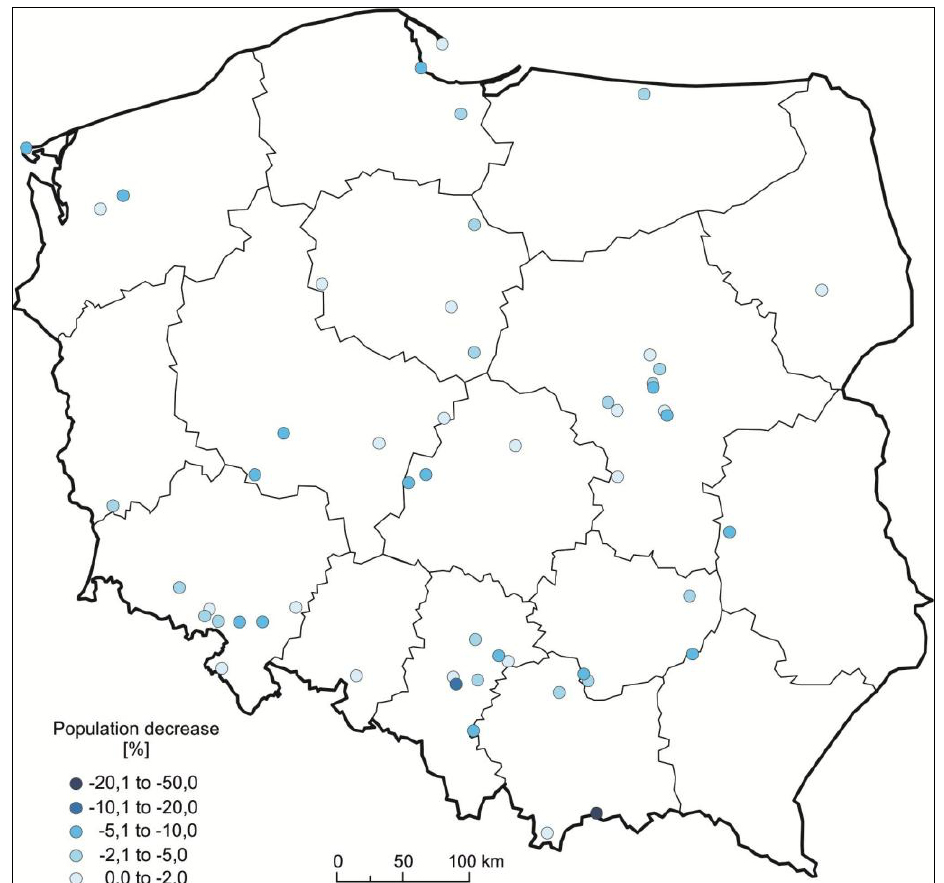
Fig. 5. Population decrease in towns of Poland, 1980-1990 (by author on the basis of Annex 2: Kantor-Pietraga,